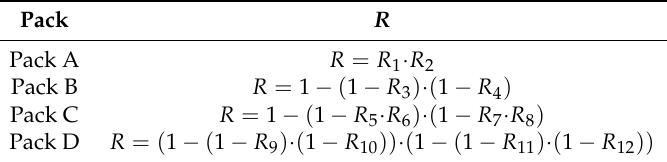
Table 2. Reliability functions of the four battery